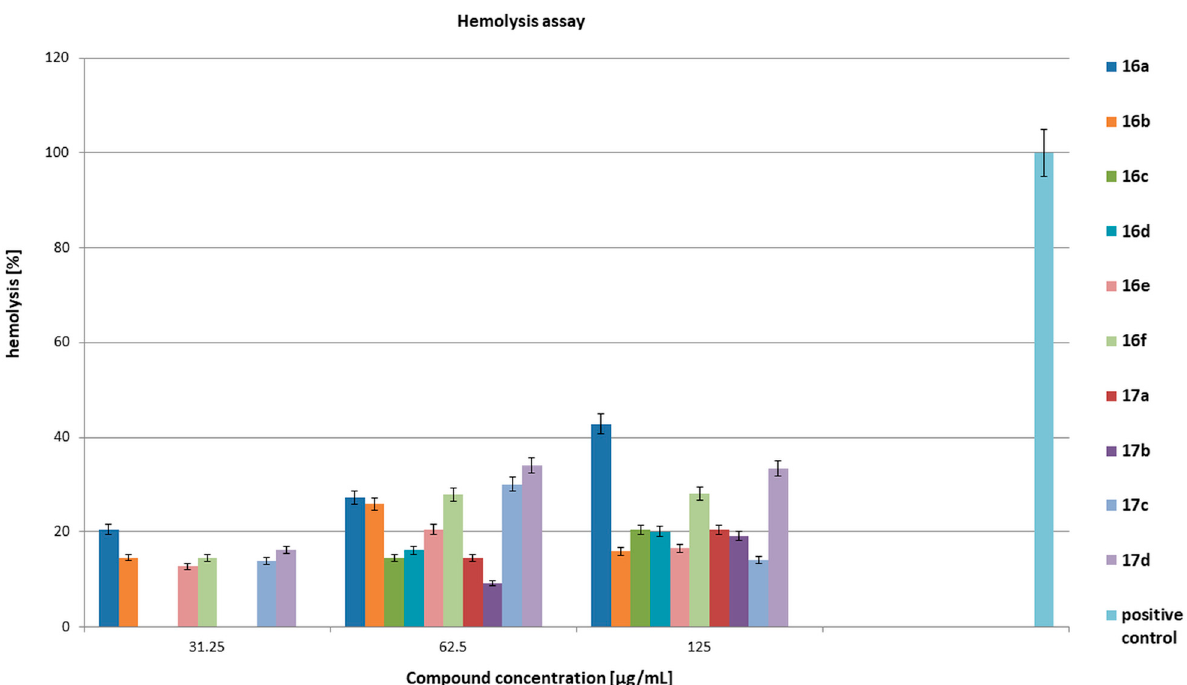
Figure 10. Hemolytic activity of the tested compounds on the domestic sheep peripheral blood. The positive control was 1% triton-x 100. The results are presented as mean values ± standard deviation (±SD) from three independent experiments. Error bars represent standard deviation.